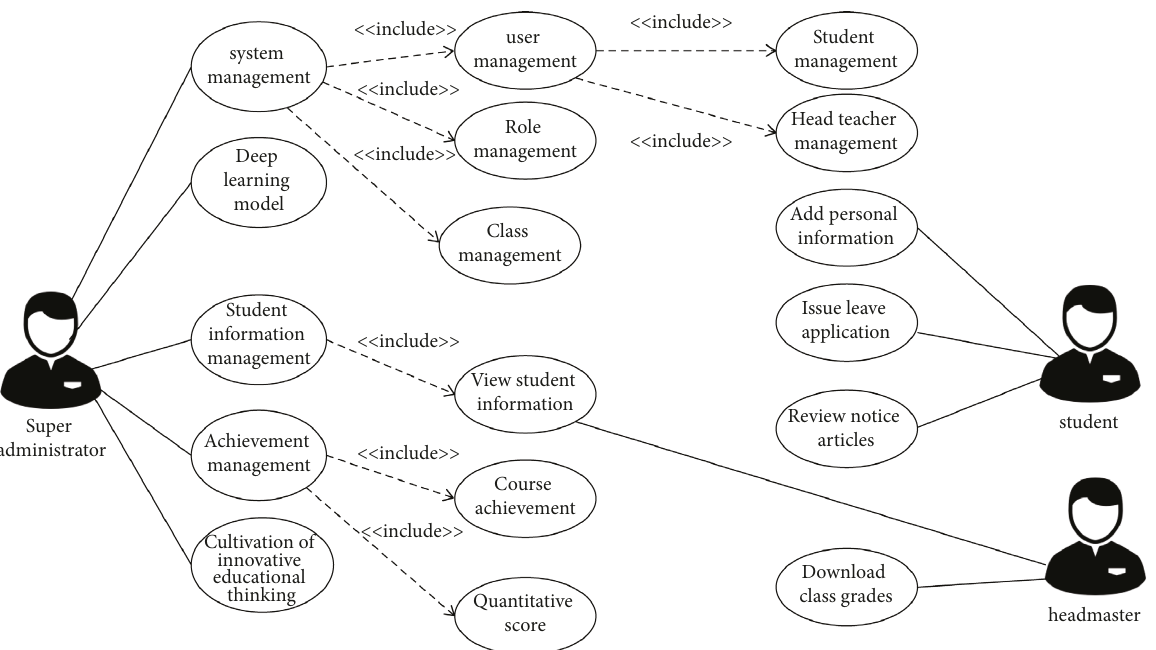
Figure 4: Construction of student innovation and entrepreneurship education based on the neural